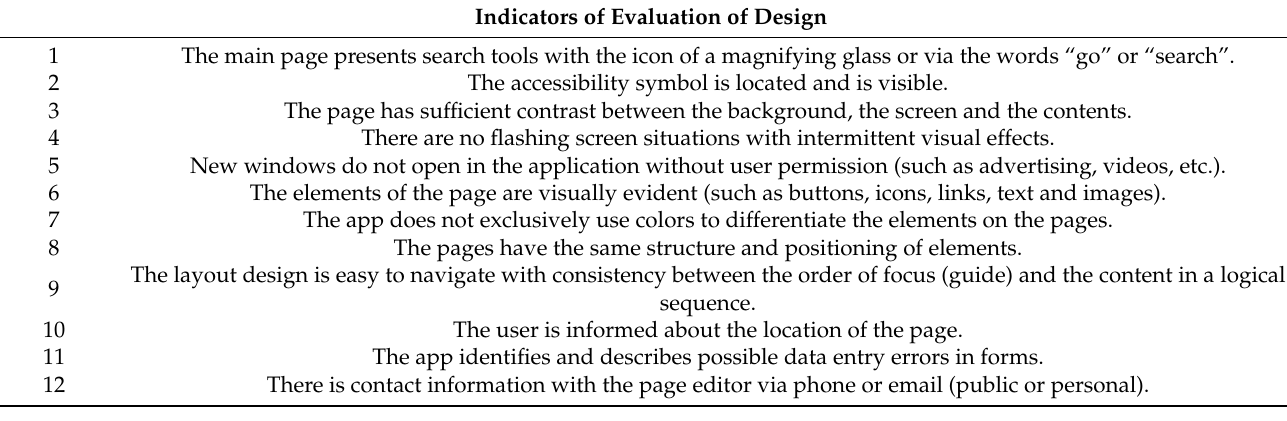
Table 1. Indicators for the analysis of the design of Portuguese apps. Indicators of Evaluation of Design